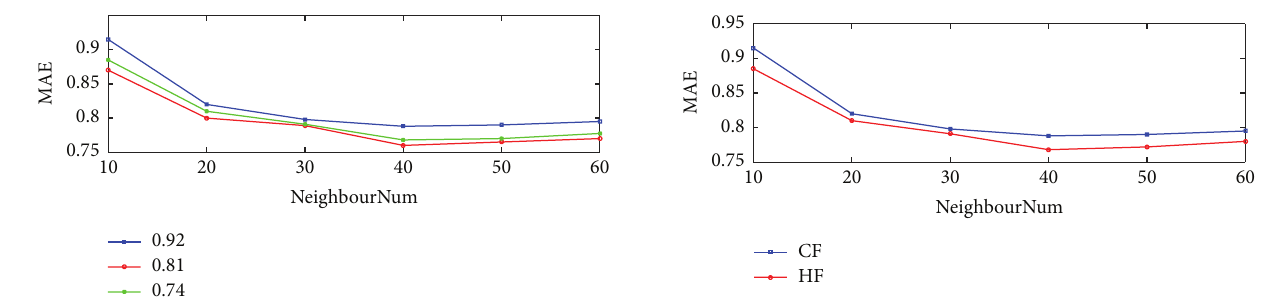
Figure 3: The impact of data sparsity on recommendation algo- rithm.